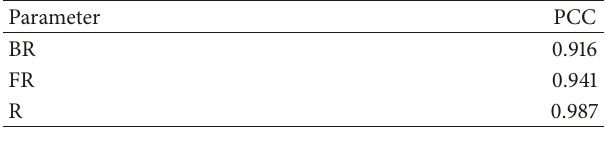
Table 20: Correlational analysis of the different application QoS factors.